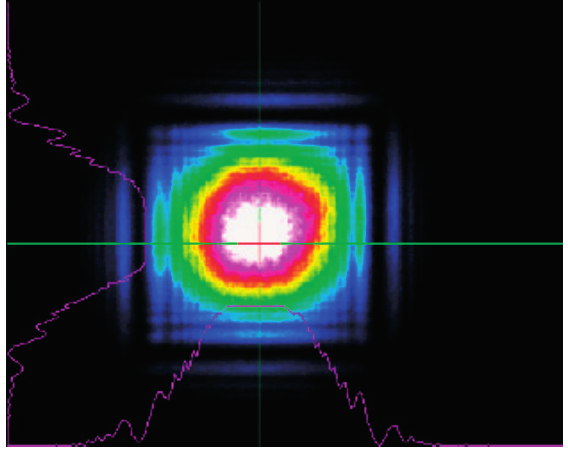
Figure 4. Image of the CCD-based beam profiler showing the pre-alignment step of the laser beam shaper,